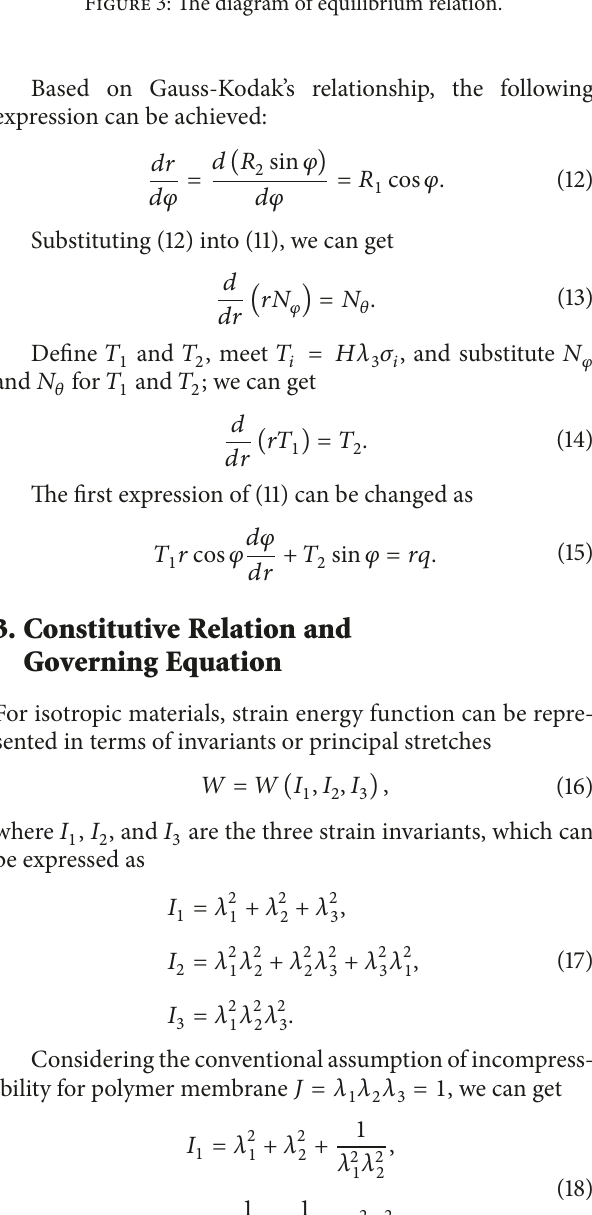
Figure 3: The diagram of equilibrium